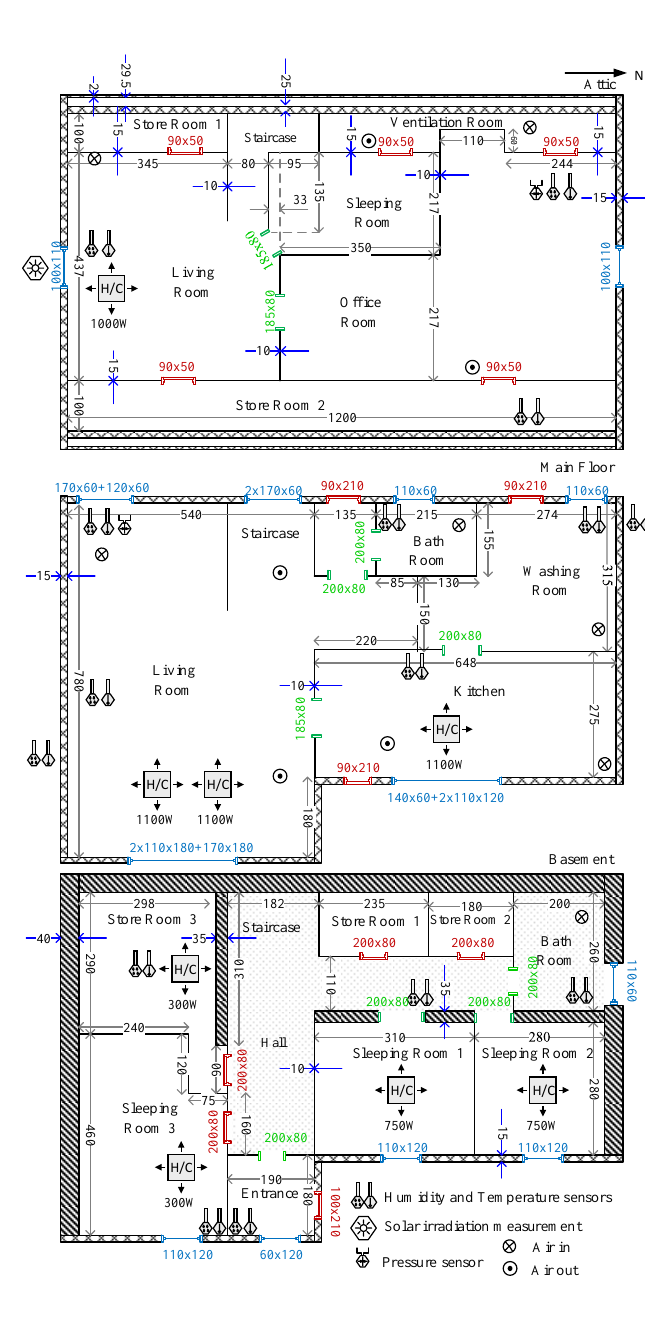
Figure 2: Configuration of the building with dimen- sions and sensor